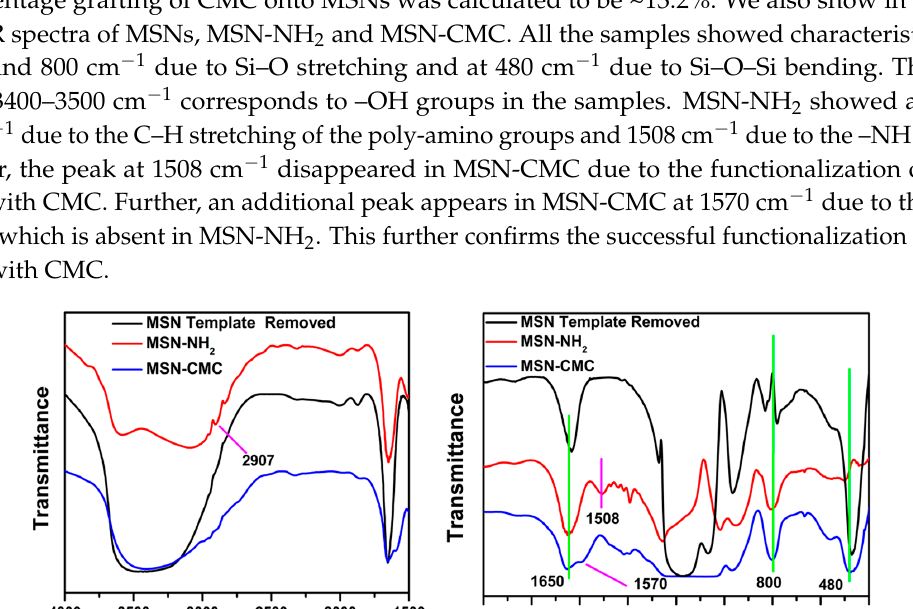
Figure 4. Fourirer Transform Infrared Spectroscopy (FT-IR) Spectra of MSN, MSN-NH 2 and MSN-CMC.